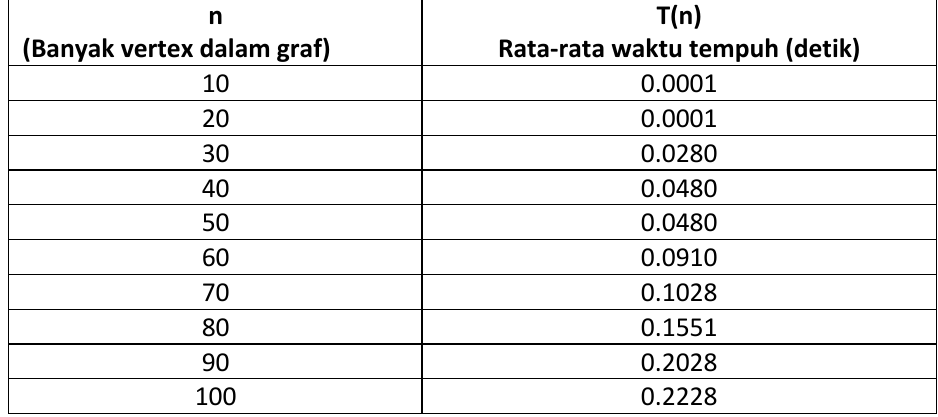
Table 2. Experimental data I Computer Processor 2.30 GHz, Cache 3 MB Intel@ Smart